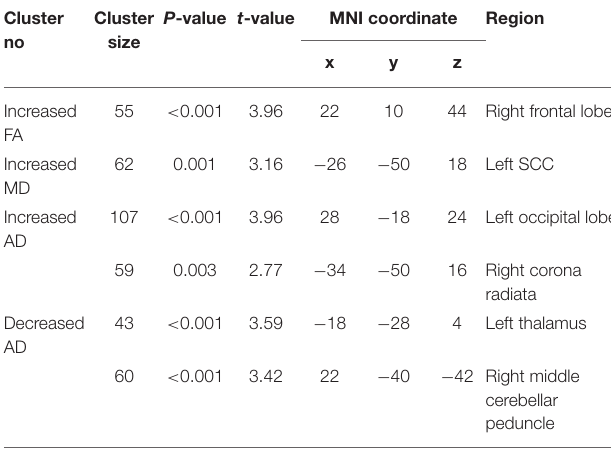
Neurological Institute; SCC, splenium of the corpus callosum.